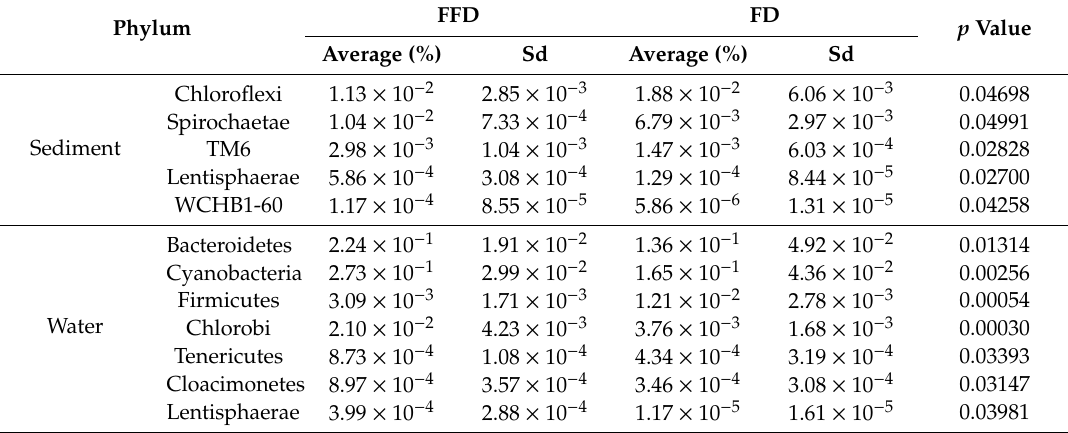
Figure 2. The microbial community distributions of sediment (marked as S) and water (marked as W) samples. ( a ) Principal coordinate analysis (PCoA) of both sediment and water samples; ( b ) weighted Unifrac distance within group; ( c ) weighted Unifrac distance between FFD and FD ponds. Table 2. The average relative abundance of significantly di ff erent phylum taxa in sediment and water